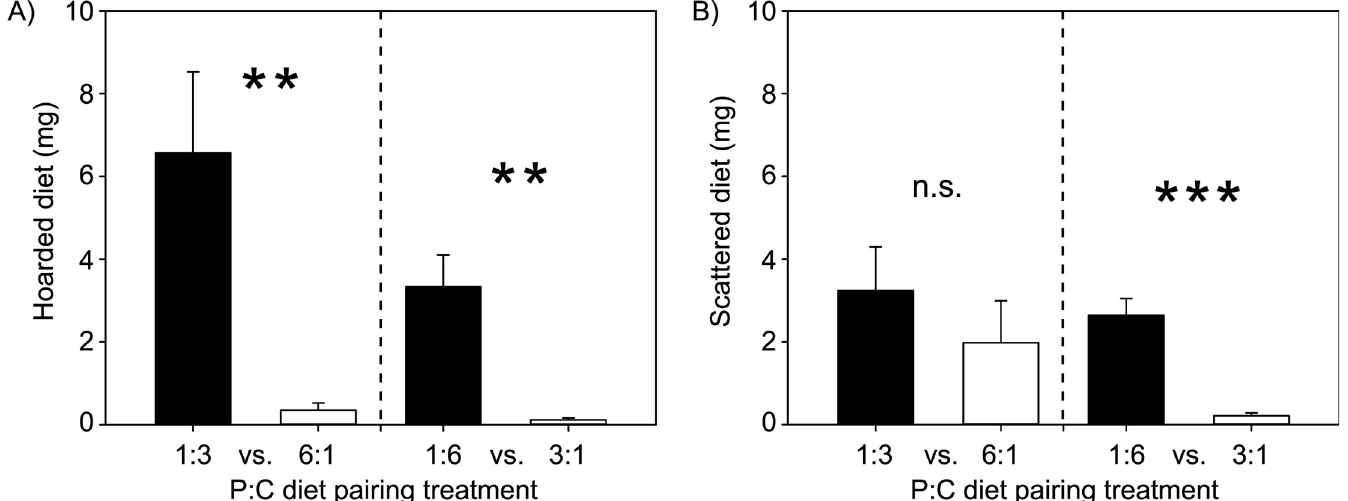
Fig 3. Post-harvest diet processing ( ± SE) after 12 days in the 2-D choice experiment, based on analyzing uneaten colored diet. (A) Colonies tended to preferentially hoard (retained inside the nest) carbohydrate-biased diets in both the 1:3 vs. 6:1 P:C pairing and the 1:6 vs. 3:1 P:C pairing treatments. (B) Colonies scattered diets evenly in the 1:3 vs. 6:1 P:C treatment, but scattered significantly more of the carbohydrate-biased diet in the 1:6 vs. 3:1 P:C treatment. Asterisks indicate the results of paired t-tests, testing difference within pairings between either hoarded or scattered diet (dry mass, mg), with n.s. = not significant, � p < 0.05, �� p < 0.01, ��� p <